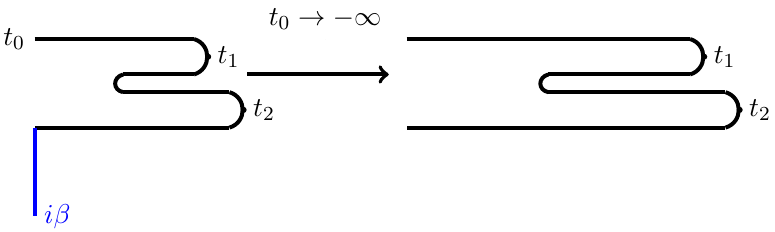
Figure 1. Contour deformation for Bogoliubov principle of weakening correlations.